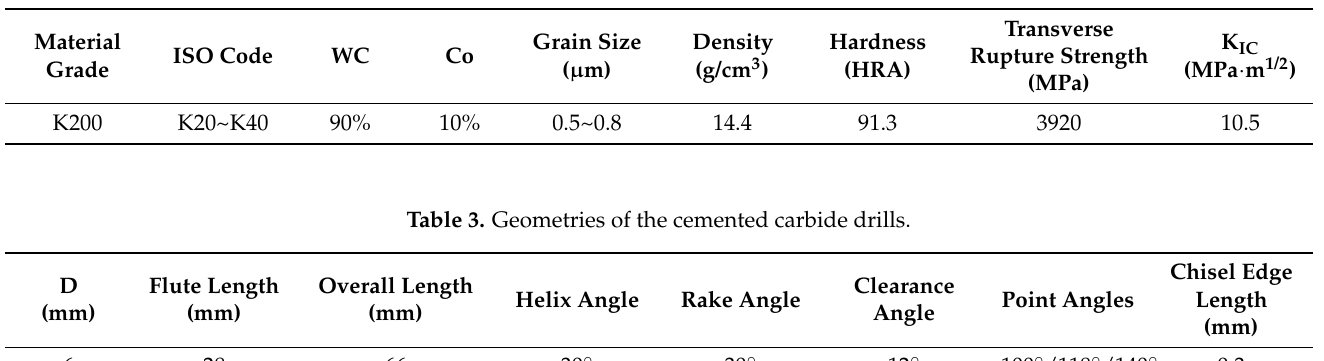
Table 2. The constituent materials of the cemented carbide drills [23].